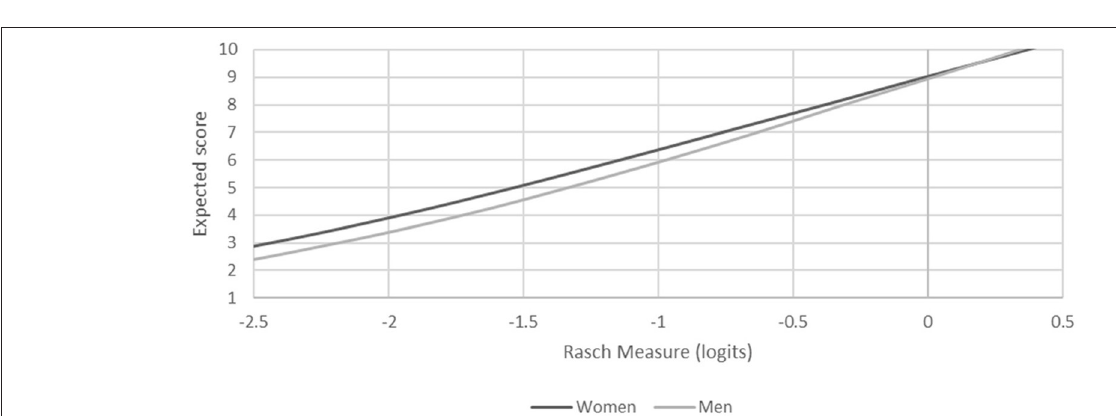
FIGURE 2 | Differential Test Functioning based on age groups.